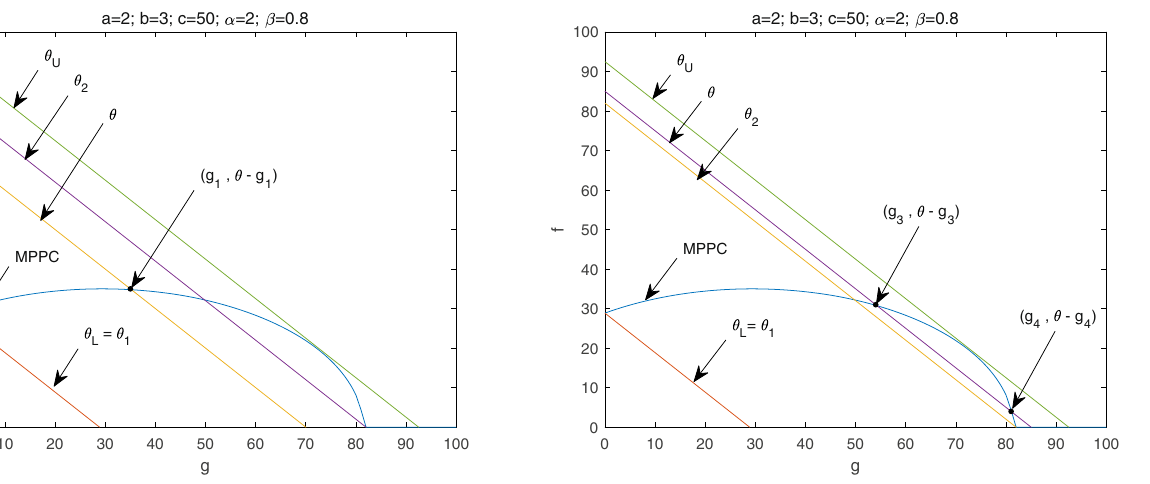
Fig. 6 The intersection ( g 1 , θ - g 1 ) when θ 1 < θ 2 .